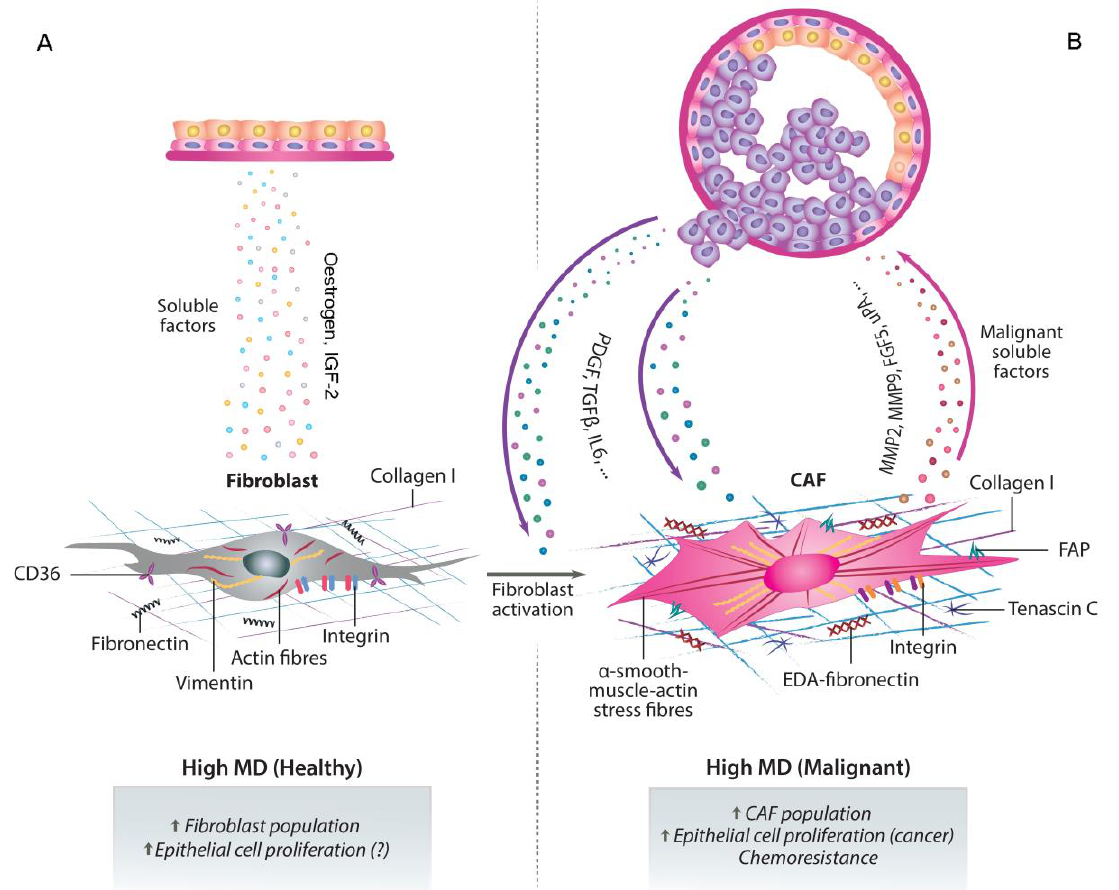
Figure 3. Paracrine crosstalk between fibroblasts and neighbouring epithelial cells. The abundance of stromal fibroblasts correlates with areas of high MD and stimulates epithelial cell proliferation by secreting copious soluble factors ( A ). The overstimulated epithelial cells, in turn, can undergo phenotypic changes and secrete fibroblast-activating factors. In these areas of high MD, the altered microenvironment can lead to the activation of fibroblasts into CAFs, which facilitate the growth and progression of the tumour cells. The secretion of growth factors, cytokines and proteases by CAFs establishes a positive feedback loop between both cell types which eventually leads to infiltration of immune cells and to chemoresistance. This pro-tumoural stroma also promotes angiogenesis, metastasis and therapy resistance ( B